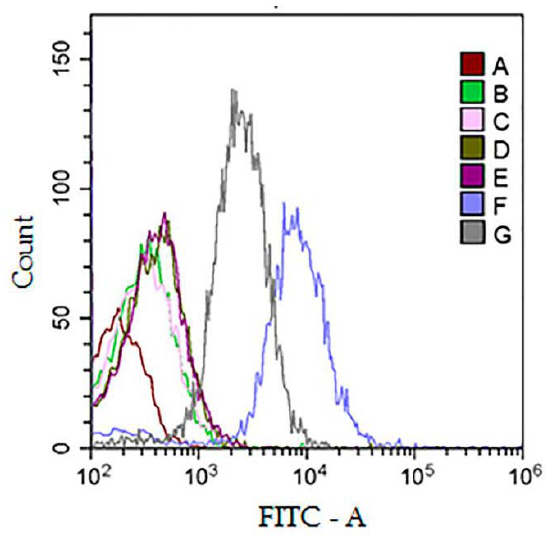
Figure 10. Flow cytometry analysis of ENVs isolated by PTPS. ( A – D ) Negative controls. ( A ) Latex particles (LPs); ( B ) LPs incubated with PEG; ( C ) LPs incubated with DEX; ( D , E ) LPs with PEG and DEX, respectively, incubated with an antibody against CD63-FITC; ( F ) LPs incubated with ENVs isolated by PTPS and labeled by an antibody against CD63-FITC; ( G ) LPs incubated with UC-ENV labeled by an antibody against